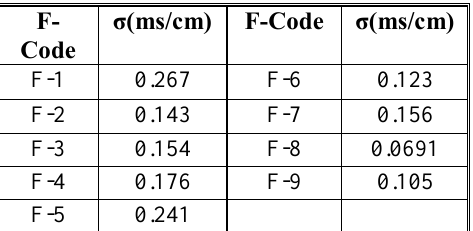
Dilution test Table 7. Conductivity measurement of LCDP